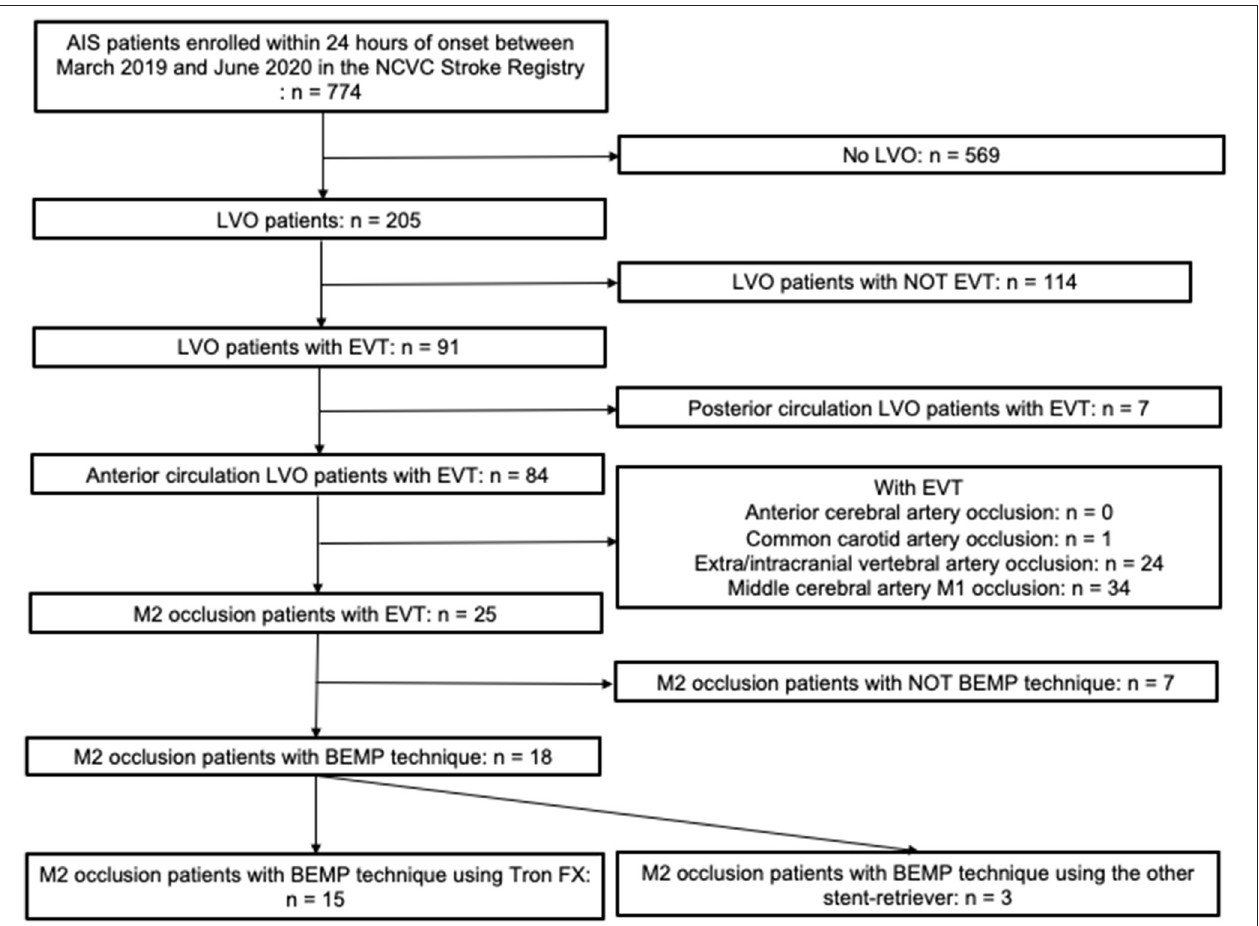
FIGURE 4 | Study flowchart. ACA, anterior cerebral artery; BA, basilar artery; BEMP, blind exchange with mini-pinning; BGC, balloon guide catheter; CCA, common carotid artery; EVT, endovascular therapy; ICA, internal carotid artery; MCA, middle cerebral artery; NCVC, National Cerebral and Cardiovascular Center; PCA, posterior cerebral artery; VA, vertebral